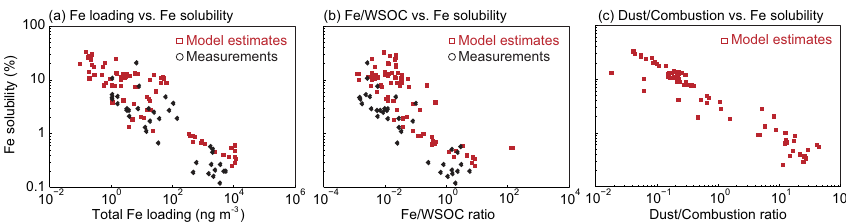
Figure 5. (a) Atmospheric loading of total aerosol Fe (ngm − 3 ) versus Fe solubility for model estimates (red squares) and measurements (black circles) over the cruise tracks. (b) The Fe / WSOC molar ratio versus Fe solubility for model estimates (red squares) and measurements (black circles) over the cruise tracks. (c) The dust / combustion ratio for soluble Fe versus percent of soluble Fe in total Fe for model results over the cruise tracks. The measurements are obtained from Wozniak et al. (2013, 2015). The number of modeled data points (84) is larger than the measurements (37), because each daily average is calculated for each sampling date at each center of cruise